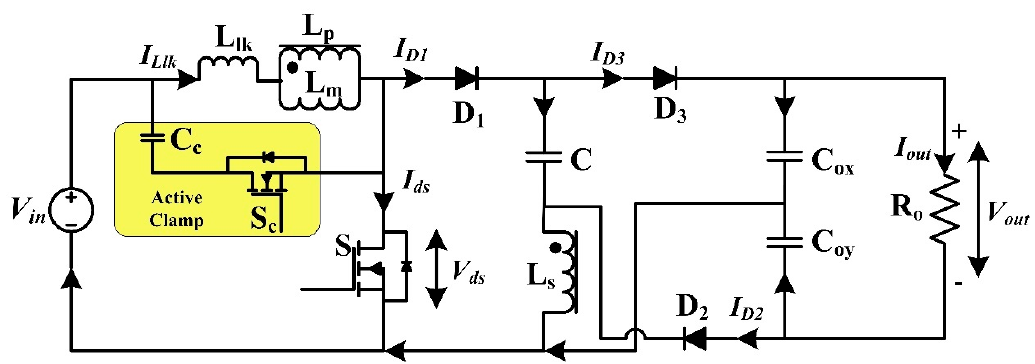
Figure 16. Proposed converter with active clamp circuit. Figure 17. Proposed converter with active clamp